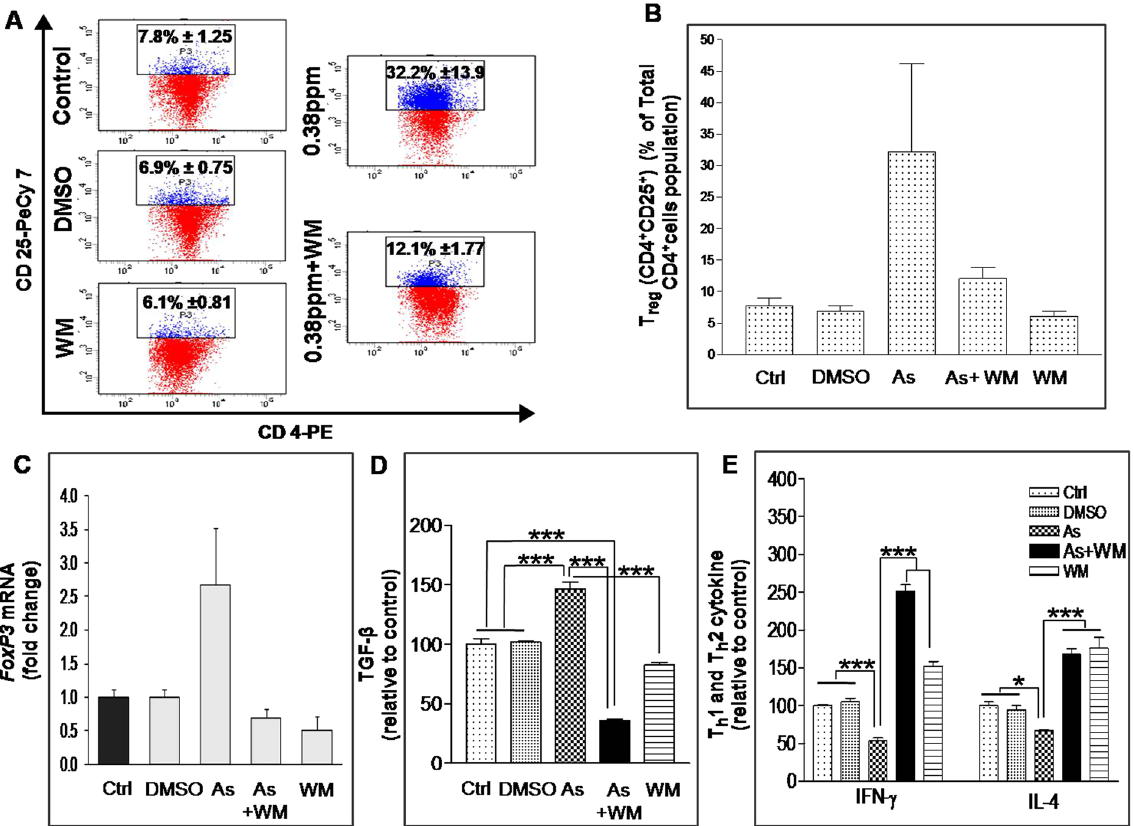
Figure 6. Effect of wortmannin on arsenic-induced altered splenic cytokine profile. Splenocytes isolated from mice treated with DMSO as vehicle, 0.38 ppm arsenic, 0.38 ppm arsenic along with wortmannin and only wortmannin group were processed to isolate CD4 + T cells using CD4 magnetic particles by positive selection. Isolated CD4 + T cells were stained with PE conjugated CD4 and PeCy7 conjugated CD25 antibody for 1 h at 37 °C. Each representative dot plot (A) and Bar graph (B) reflects percent population of CD4 + CD25 + T cells in total parent CD4 population. (C) FoxP3 transcript level in isolated CD4 + T cells. (D) Levels of TGF- β , (E) IFN- γ and IL-4 in splenocyte culture supernatant expressed as percent of control. Values are mean ± S.E. (n = 3–5 per group). * p < 0.05, ** p < 0.01 and *** p < 0.001 compared to control. Ctrl; Control; DMSO; Dimethyl sulfoxide; As; 0.38 ppm arsenic; WM;